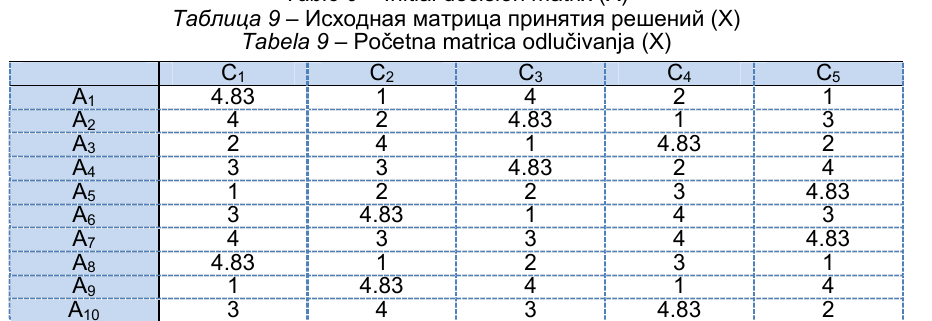
Table 9 – Initial decision matrix (X) Таблица 9 – Исходная матрица принятия решений (X)